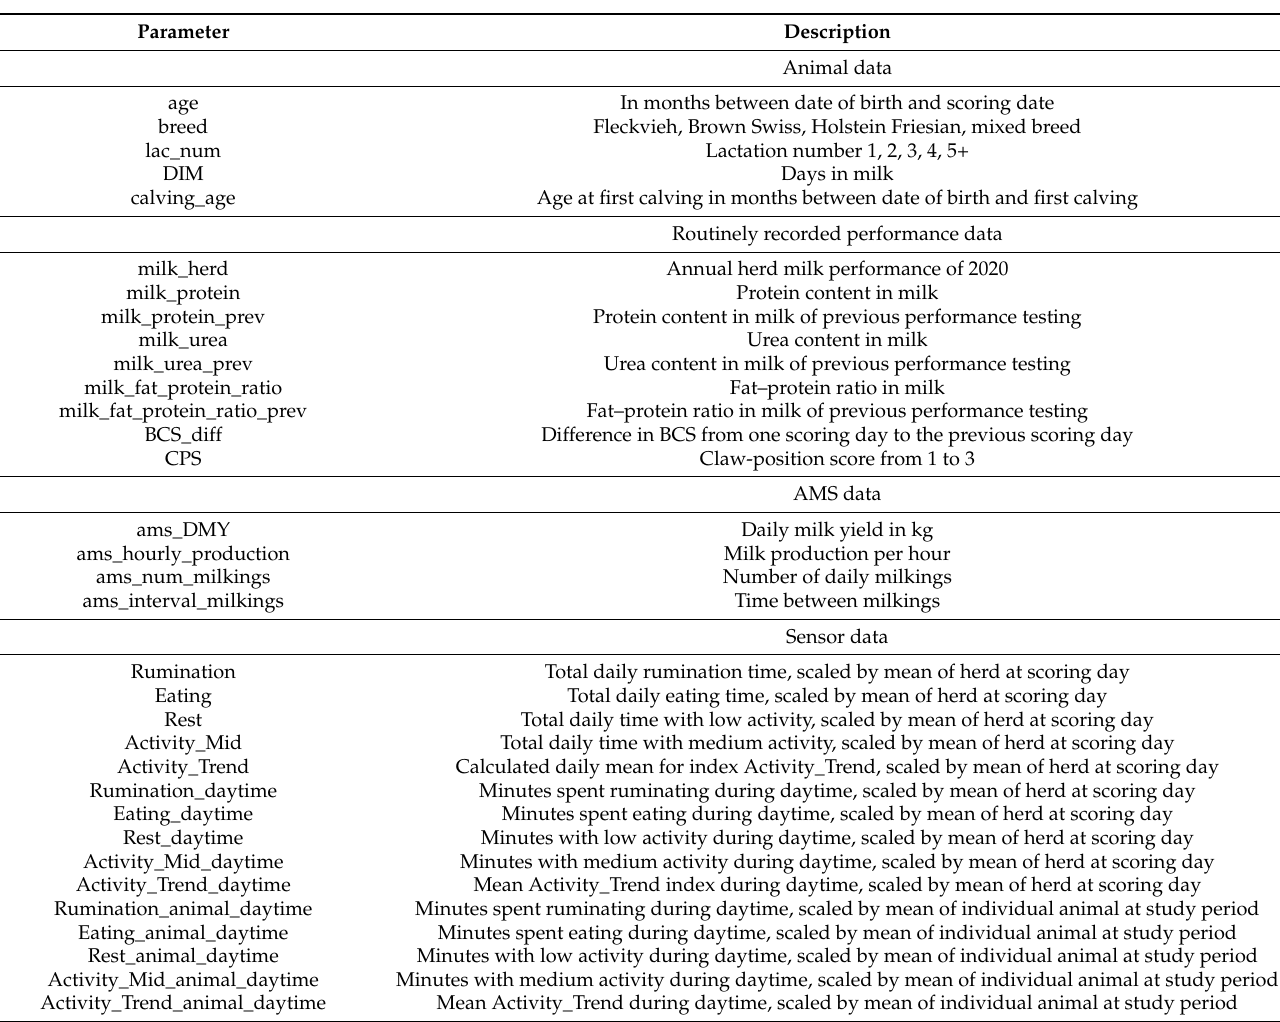
Table 1. Parameters that were included in the final detection